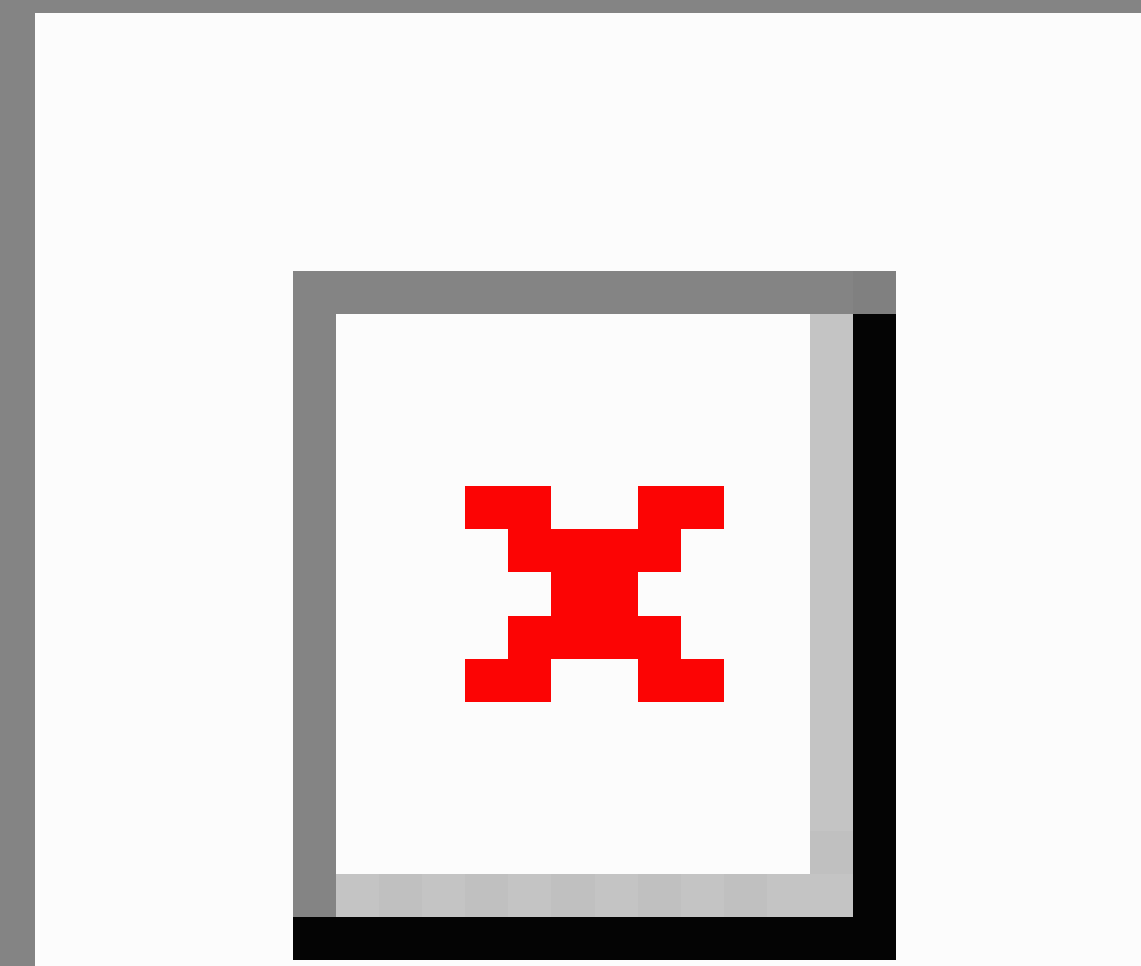
Figure 2. Pill-counting adherence and regimen switches for PrEP among GSN users and nonusers during follow-up The difference in the rate for pill counting adherence and regimen switching between GSN users and nonusers at each follow-up visit was marked as * P <.20, ** P <.05. E → D: Switching from event-driven to daily regimen; GSN: geosocial networking; PC: pill counting; PrEP: pre-exposure